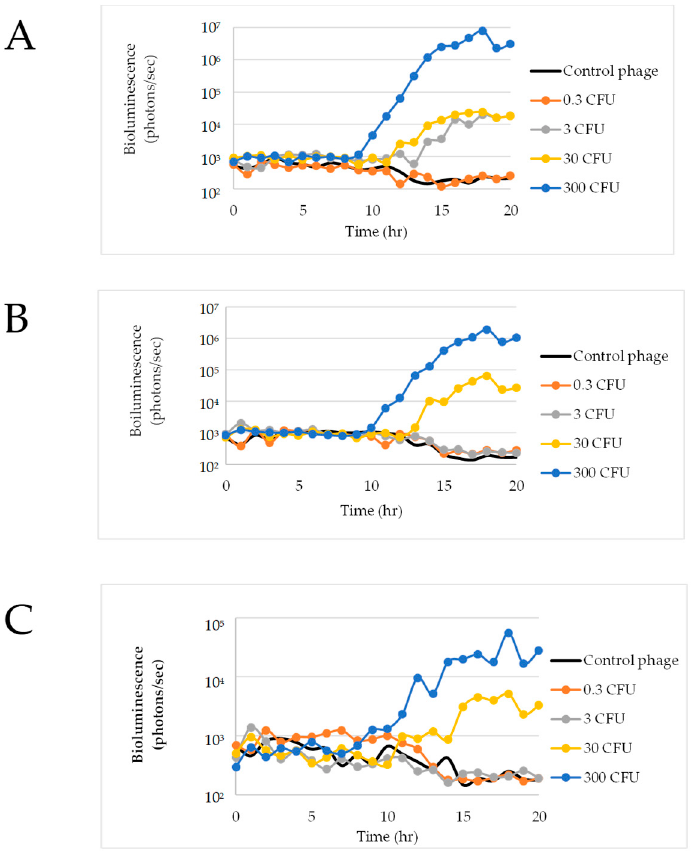
Figure 6. Φ V10 nluc infectivity in 650 mL mTSB Nalgene bottles. Replicates ( A ) 1, ( B ) 2, and ( C )